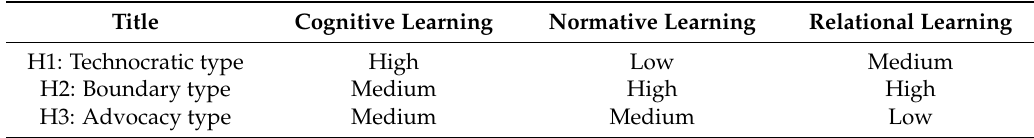
Table 3. Expected learning effects for ideal type